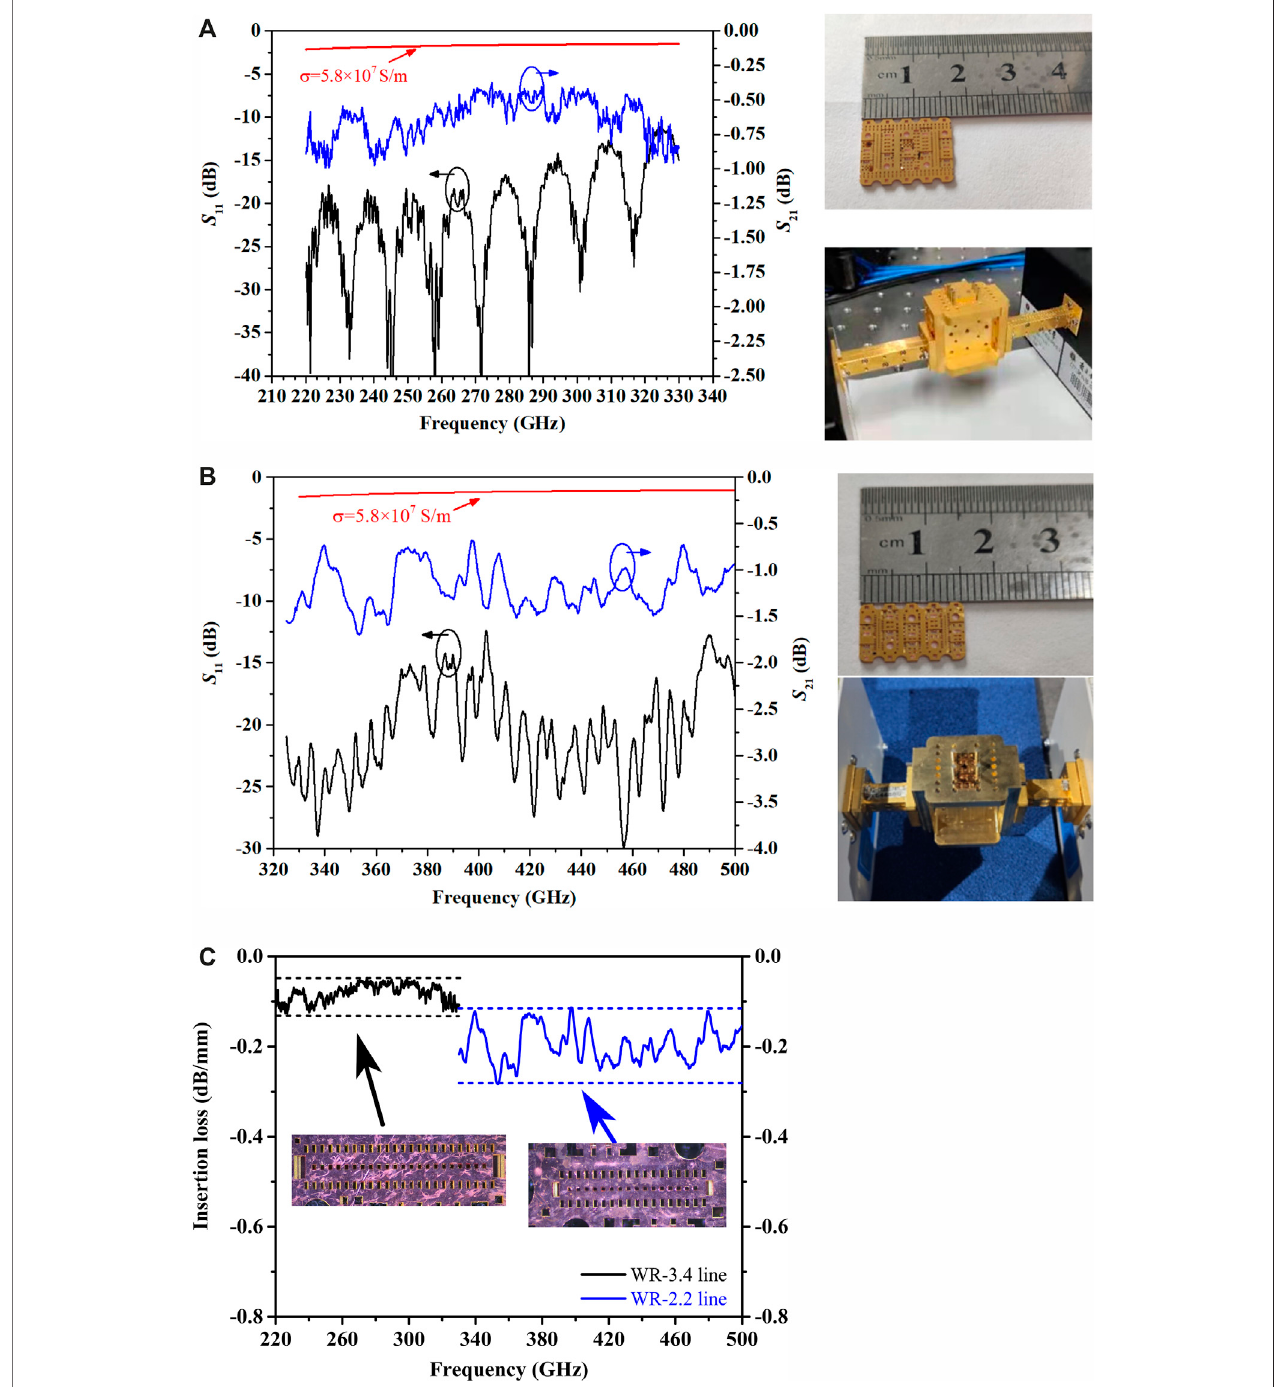
FIGURE 7 | Measured results of two types of waveguides. (A) S-parameters of a WR-3.4 waveguide line with a length of 7.8 ° mm. (B) S-parameters of a WR-2.2 waveguide line with a length of 6 ° mm. (C) Insertion loss per unit length of two types of waveguides